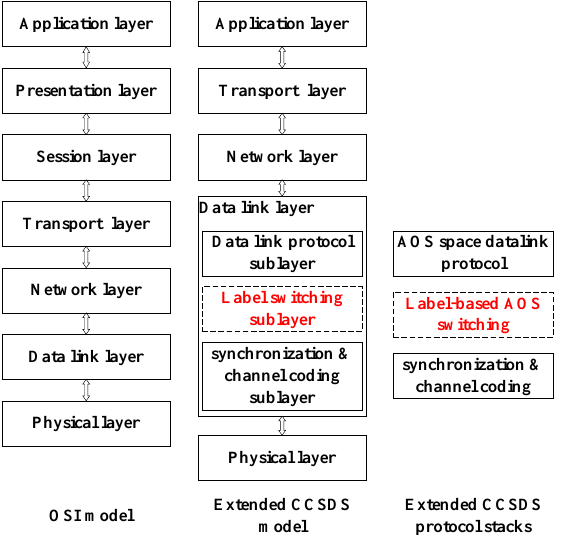
Figure 2. The label-based CCSDS AOS frame switching. ( a ) The CCSDS recommended AOS frame. ( b ) The proposed AOS frame with extended control field. ( c ) The principle of label swapping for the AOS frame according to LFIB.